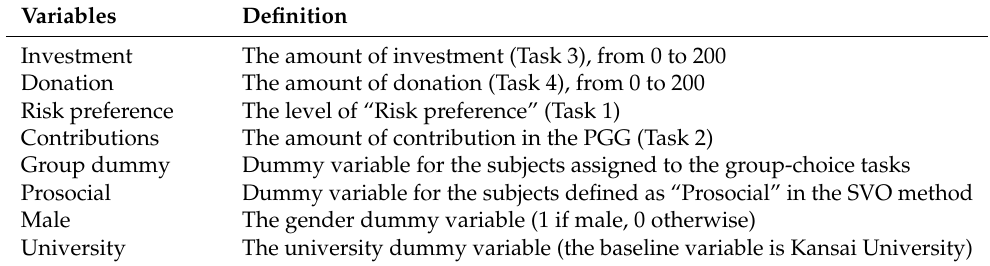
Table 2. Variable definitions.